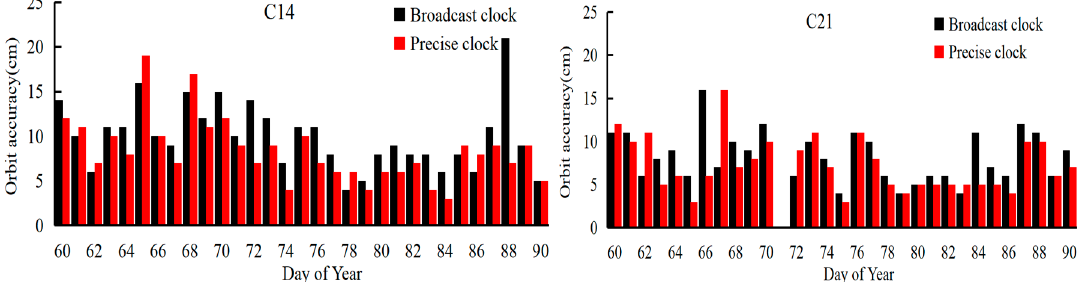
Figure 9. Daily orbit accuracy comparison of the two satellites (C14 and C21) resulting from Scenario 1 (black) and Scenario 2 (red) during the 31 day period.